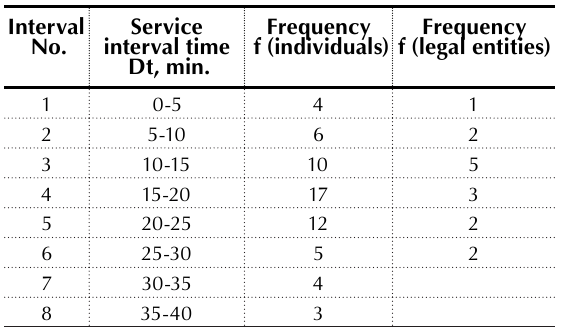
Table 6. Bank customer service time